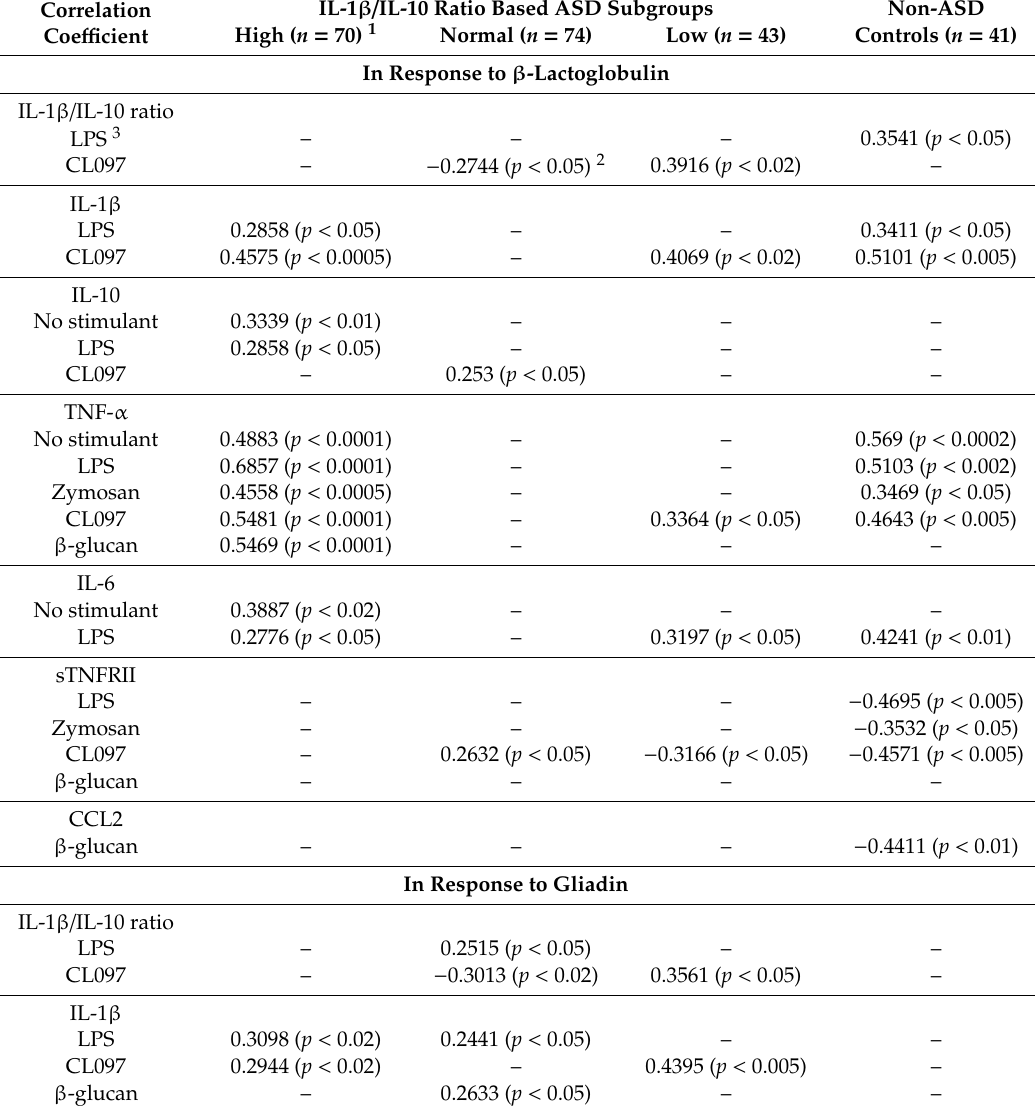
Table 6. Correlations between TNF- α production by PBMCs and monocyte cytokine